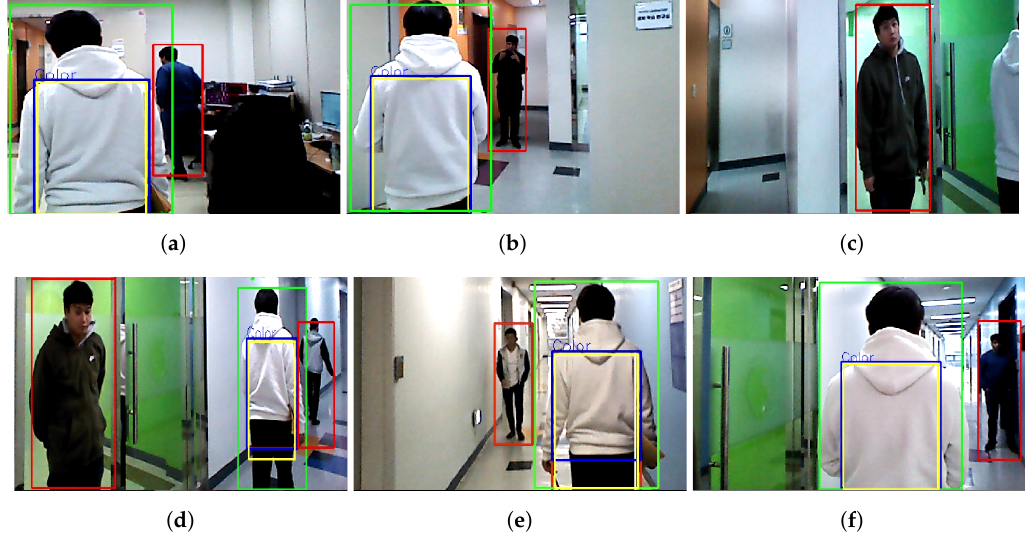
Figure 8. Snapshots of the robot’s field of view while performing the human following experiments: ( a ) It begins to follow the target wearing the white hooded t-shirt. ( b ) The target is walking out of the laboratory, and another person is standing in the corridor outside the door. ( c ) The robot loses the target momentarily at the laboratory’s door. ( d ) The robot re-tracks the target immediately. ( e ) The robot follows well while another person is walking in the opposite direction. ( f ) The robot follows well despite illumination changes while the other person is standing in the middle of the